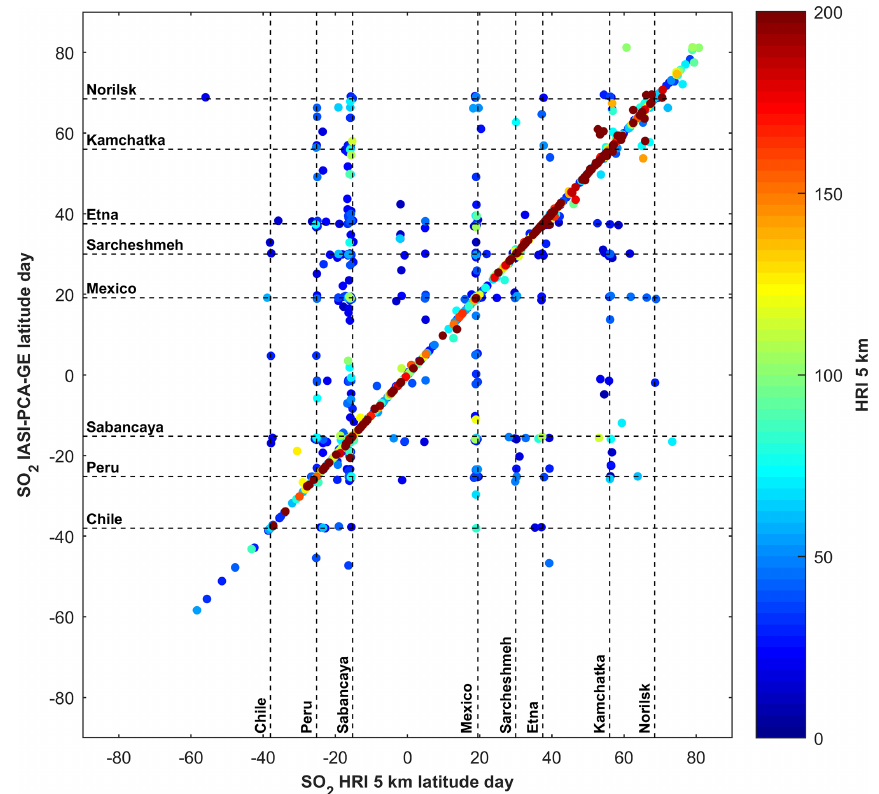
Figure 7. Comparison of latitudes corresponding to the daily maxima detected for both the IASI-PCA-GE SO 2 signal intensity and HRI product between 2013 and 2022 with IASI-B L1C data during the day. The dashed lines show location discrepancies.